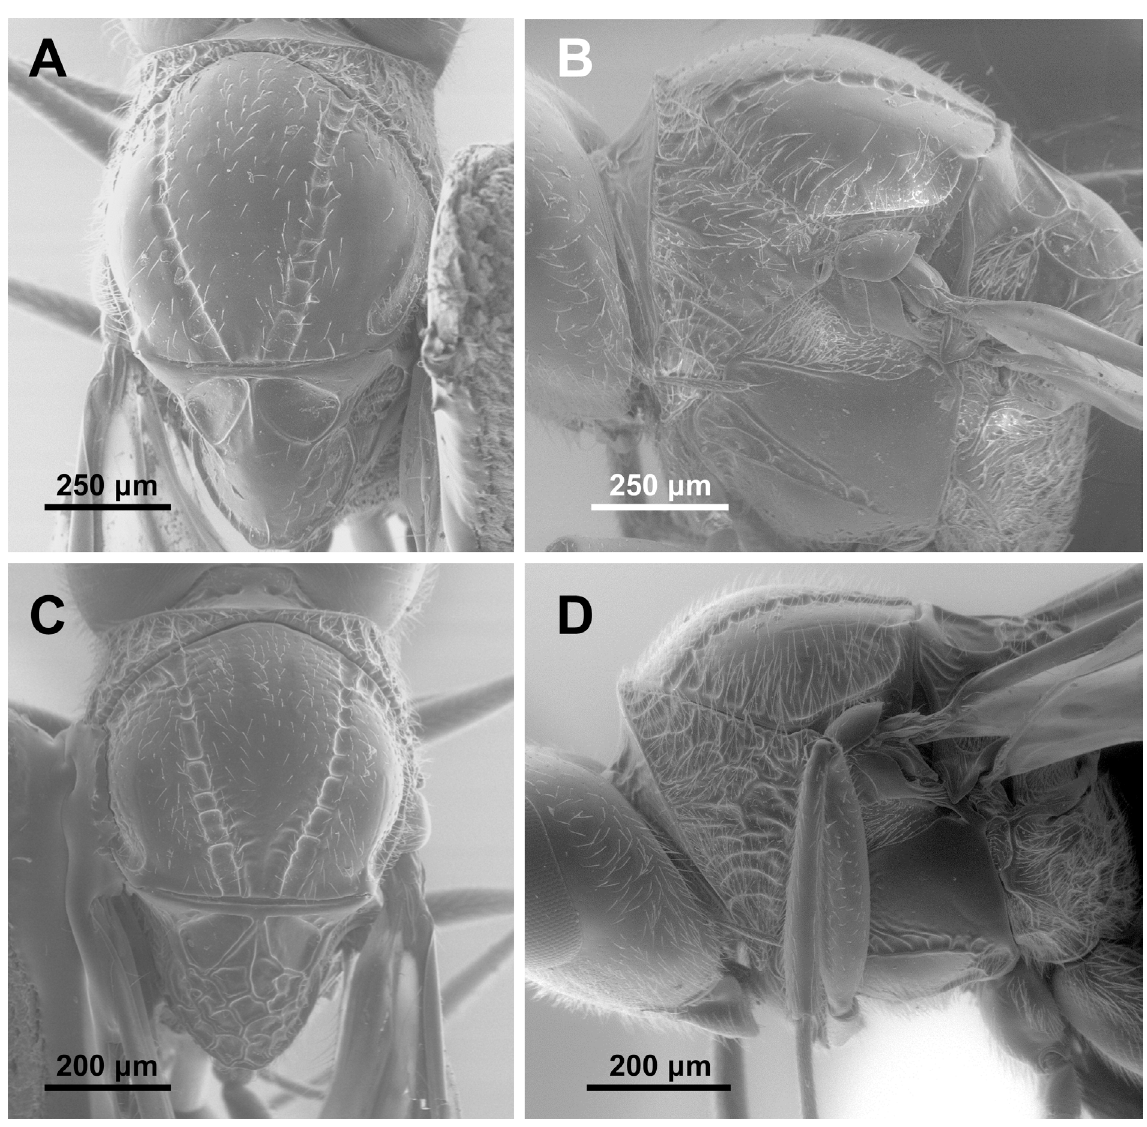
Fig. 1. A–B . Anacharis antennata Belizin, 1951, mesosoma. A . Dorsal view. B . Lateral view. – C–D . A. parapsidalis Belizin, 1951, mesosoma. C . Dorsal view. D . Lateral